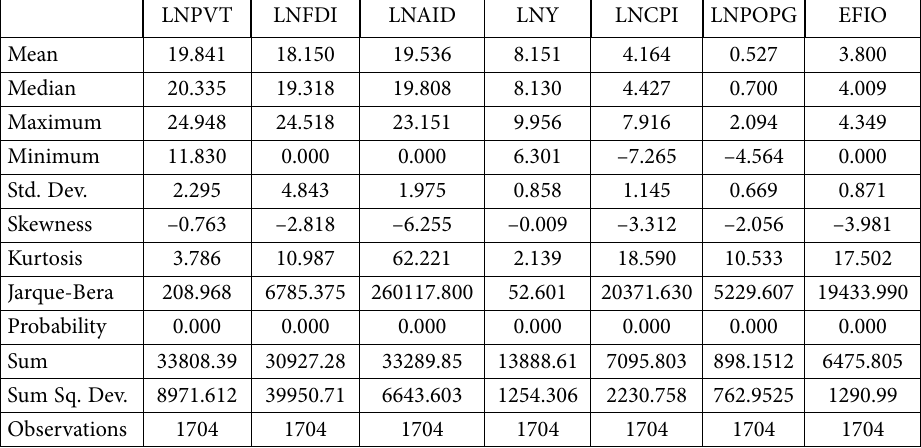
Table 3. Summary